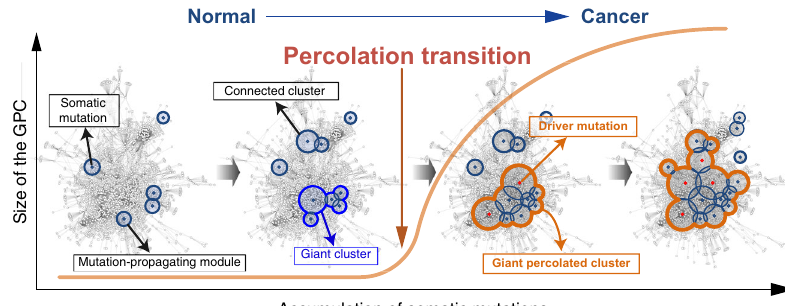
Fig. 6 A schematic of a percolation transition of cooperative mutational effects during